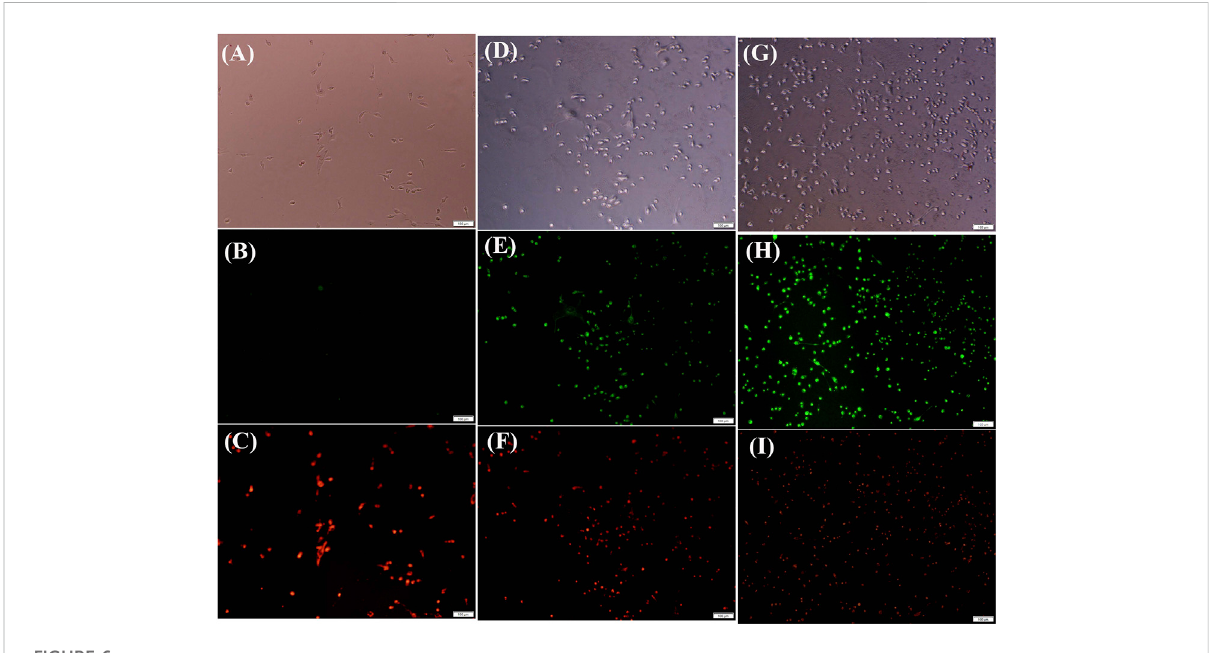
FIGURE 6 MMP was detected by JC-1 dye staining visualized with a fl uorescence microscope. Control (A,B,C) , for 40 μ M (D,E,F) , 80 μ M (G,H,I) after treated with complex 5 for 24